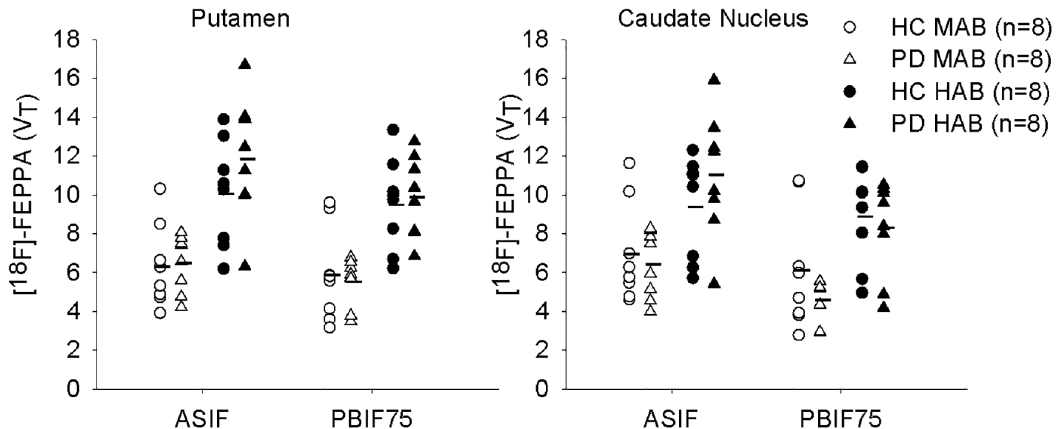
Fig 6. Comparison of total distribution volume ( V T ) between healthy controls and PD patients calculated with ASIF and PBIF75 for putamen (left) and caudate (right). Estimation with PBIF75 led to same conclusionas with the ASIF; that there is no difference from disease(p = 0.2 in Caudateand p = 0.8 in the Putamen using PBIF vs p = 0.4 in Caudateand p = 0.7 in Putamen using ISIF) and that there is a difference due to genotype(p = 0.001 in Caudateand p = 0.002 in Putamen using PBIF vs p = 0.001 in the Caudateand p = 0.0008 in Putamen using ASIF). Images were partial volume effect corrected prior to TAC